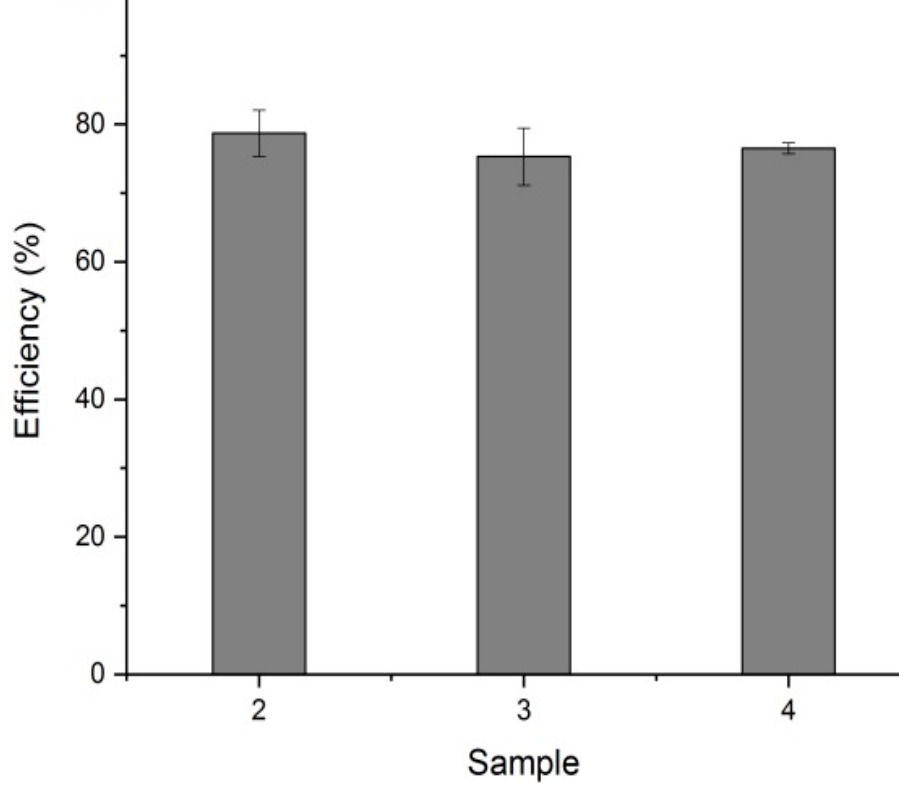
Figure 7. Removal efficiency change of Cu 2+ in the liquid phase depending on the sample’s conditions Figure 7. Removal e ffi ciency change of Cu 2 + in the liquid phase depending on the sample’s conditions (Sample 2: 0.1% Al 2 (SO 4 ) 3 with Cu 2+ , Sample 3: 0.3% (Al 2 (SO 4 ) 3 ) with Cu 2+ , Sample 4: 0.5% Al 2 (SO 4 ) 3 (Sample 2: 0.1% Al 2 (SO 4 ) 3 with Cu 2 + , Sample 3: 0.3% (Al 2 (SO 4 ) 3 ) with Cu 2 + , Sample 4: 0.5% Al 2 (SO 4 ) 3 with Cu 2+ ). with Cu 2 +